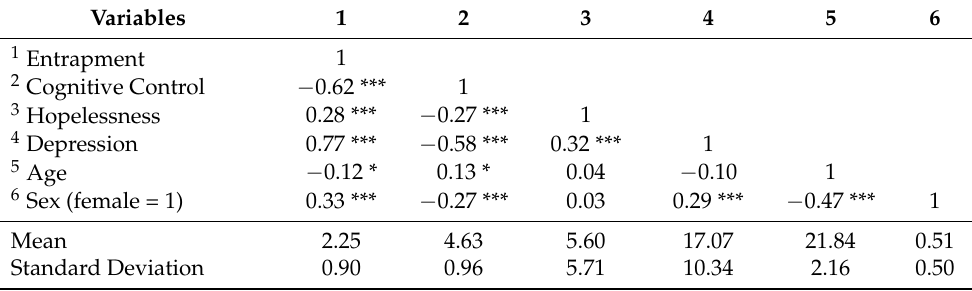
Table 1. Descriptive statistics and intercorrelations among the study variables ( N =